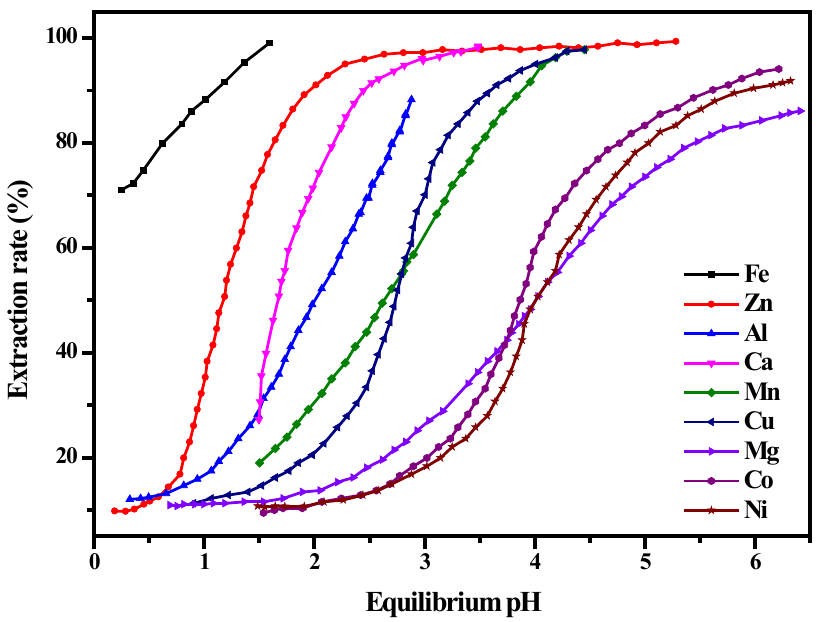
Figure 4. Extraction and separation curves of P204 at different pH values.